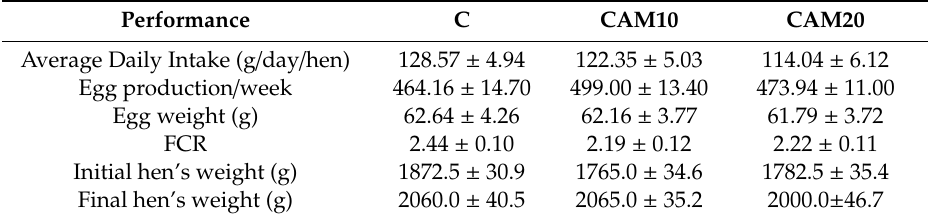
Table 4. E ff ect of camelina cake in laying hen diets on average daily intake, egg production, egg weight, and feed conversion ratio (FCR) from 21 to 51 weeks of age (Control diet—C, camelina diets—CAM10 and CAM20; mean ± SE).